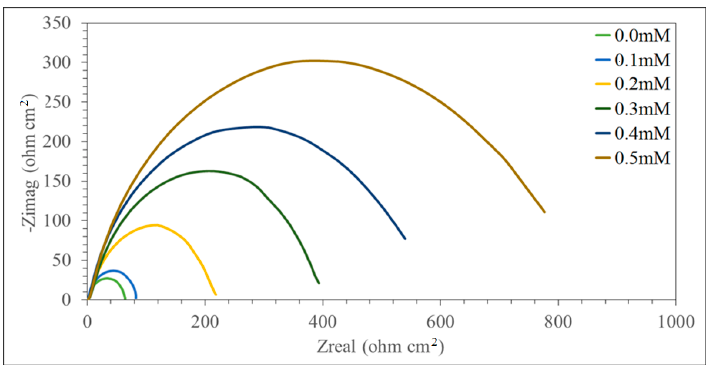
Figure 1. Nyquist plot for MS (Mild steel) in one normal sulfuric acid at various concentrations of Table 1. CPE (constant phase element) data matching that of MS in a corrosive solution with various concentrations of the DMBHC at 30 °C.